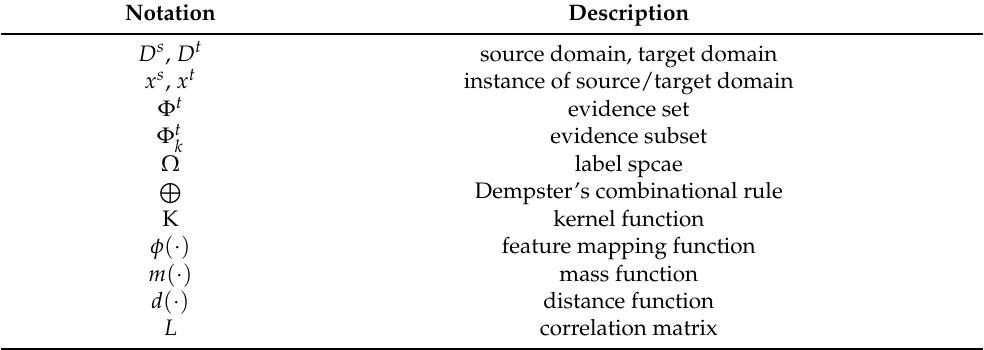
Table 1. Notations used in this paper.